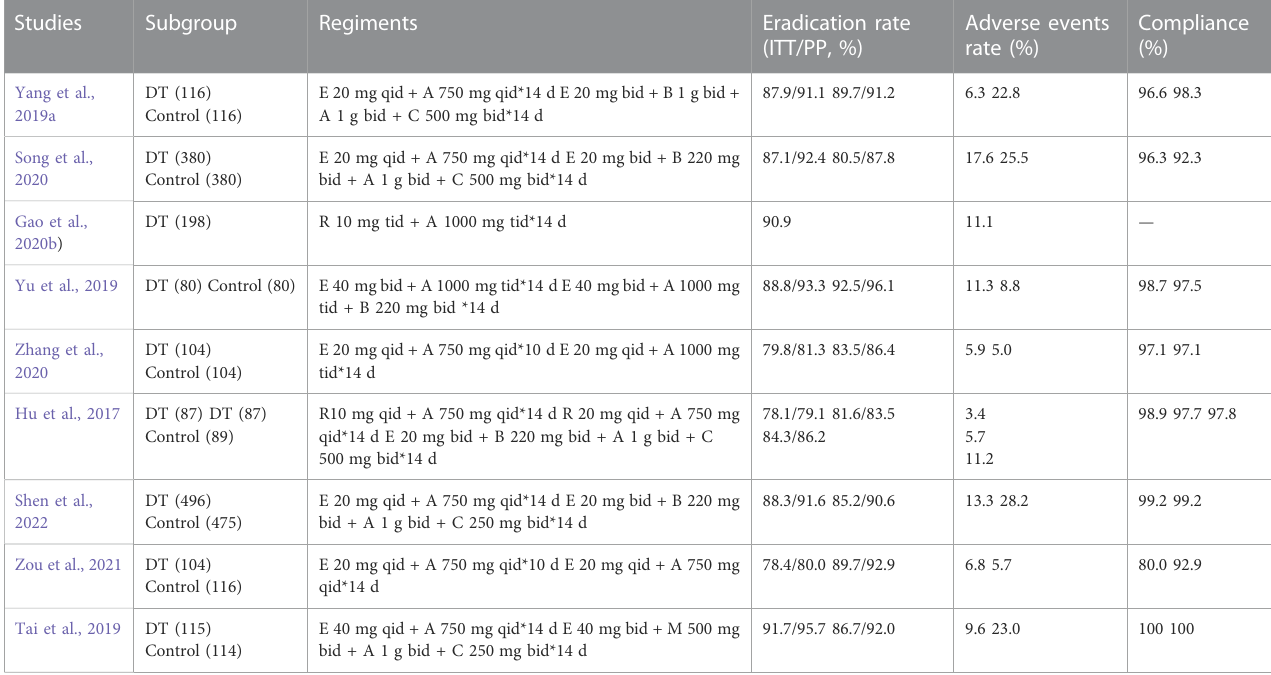
TABLE 4 Characteristics of studies.